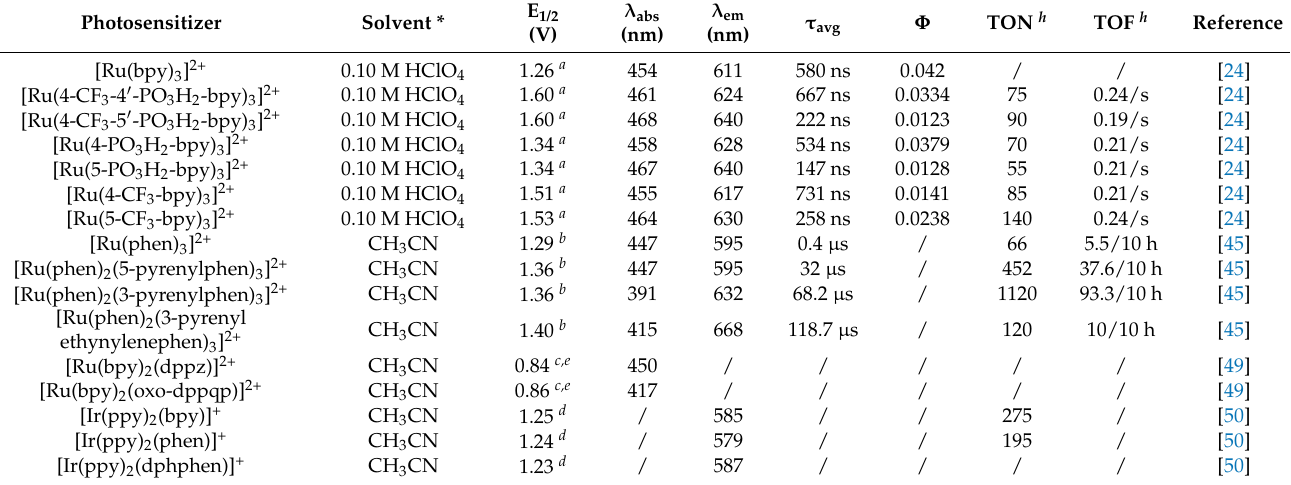
Table 1. Summary of the properties of the partial noble-metal-based photosensitizers in this review.